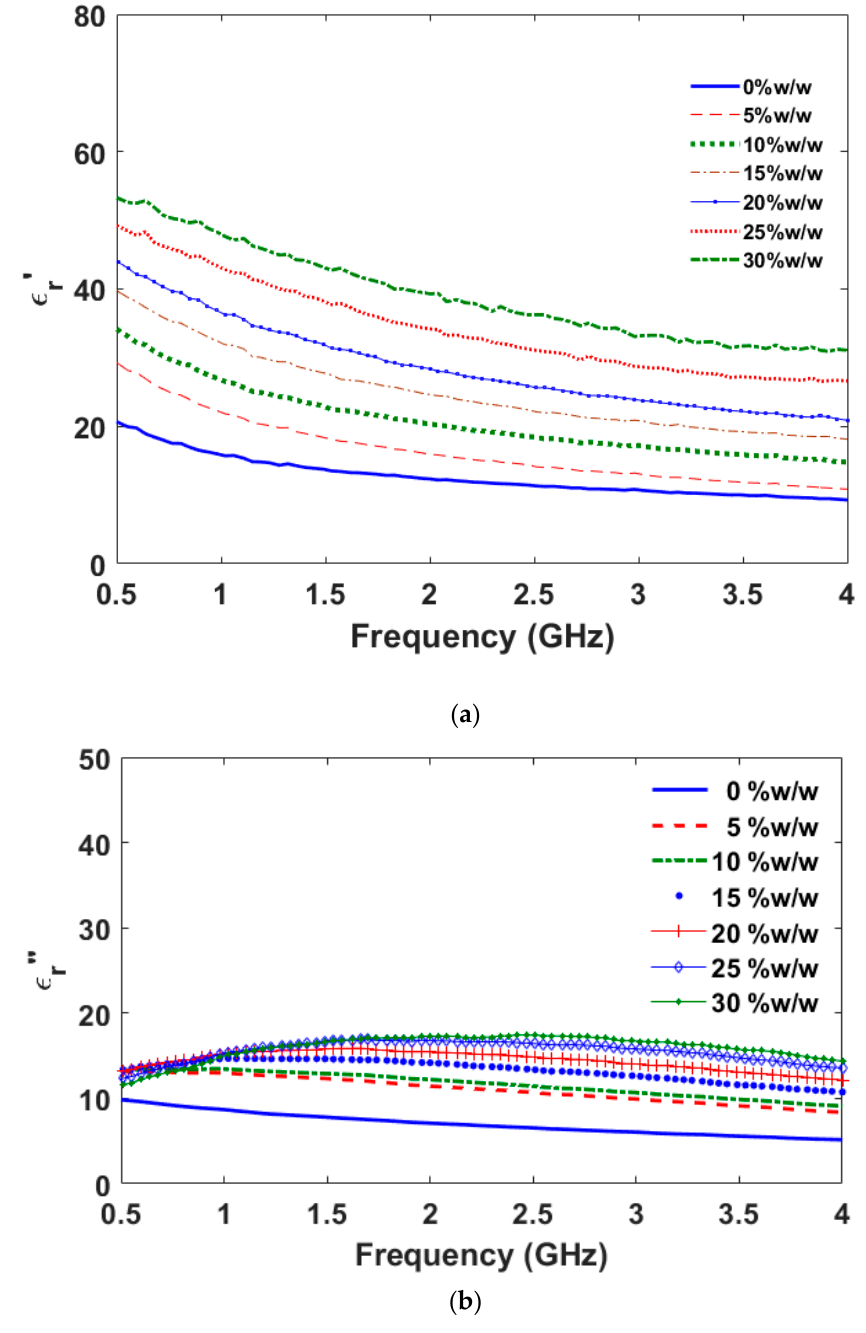
Figure 8. ( a ) Real part ( b ) imaginary part of the complex relative permittivity of honey samples which are adulterated by water with different concentrations over the frequency range of 0.5–4.0 GHz at the temperature of 25 ◦